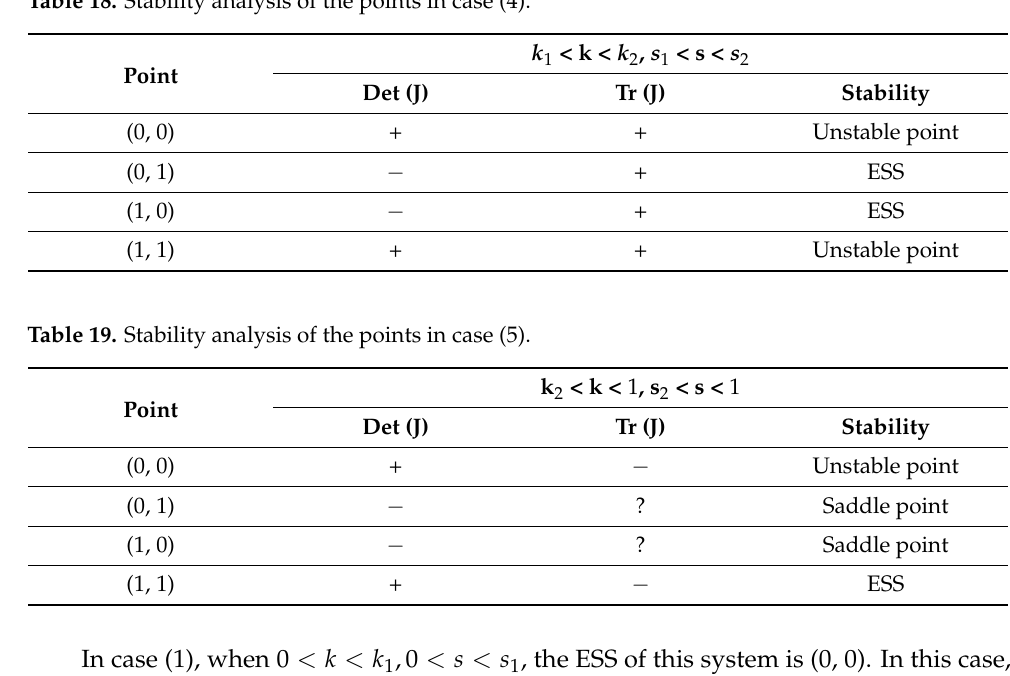
Table 18. Stability analysis of the points in case (4).